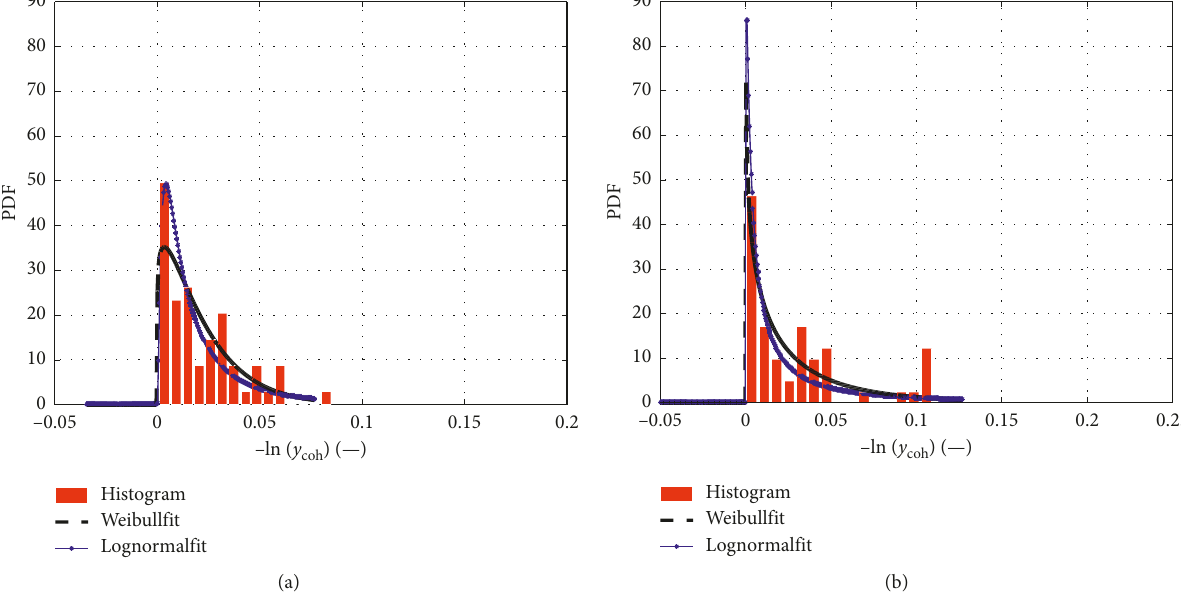
Figure 19: Results for lognormal and Weibull distributions of coherence coefficients at 1.8Hz with lateral distances of (a) 1m and (b)